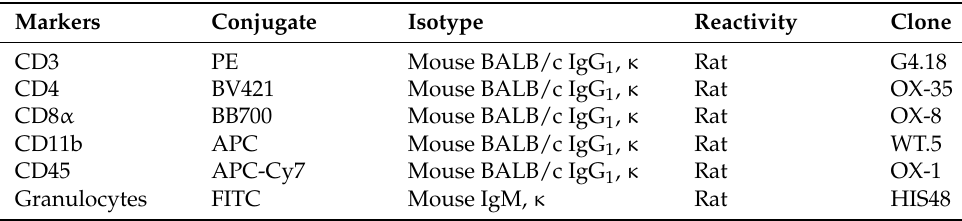
Table 1. Monoclonal antibodies used for flow cytometric